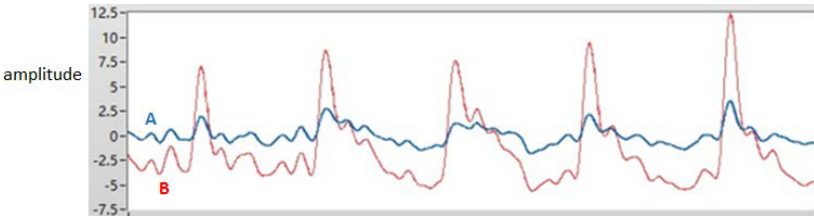
Figure 11. The processed pulse waves.